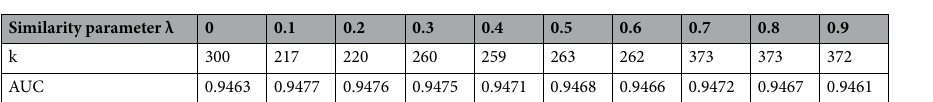
Table 2. Performance comparison of DMWNN model with different parameters.